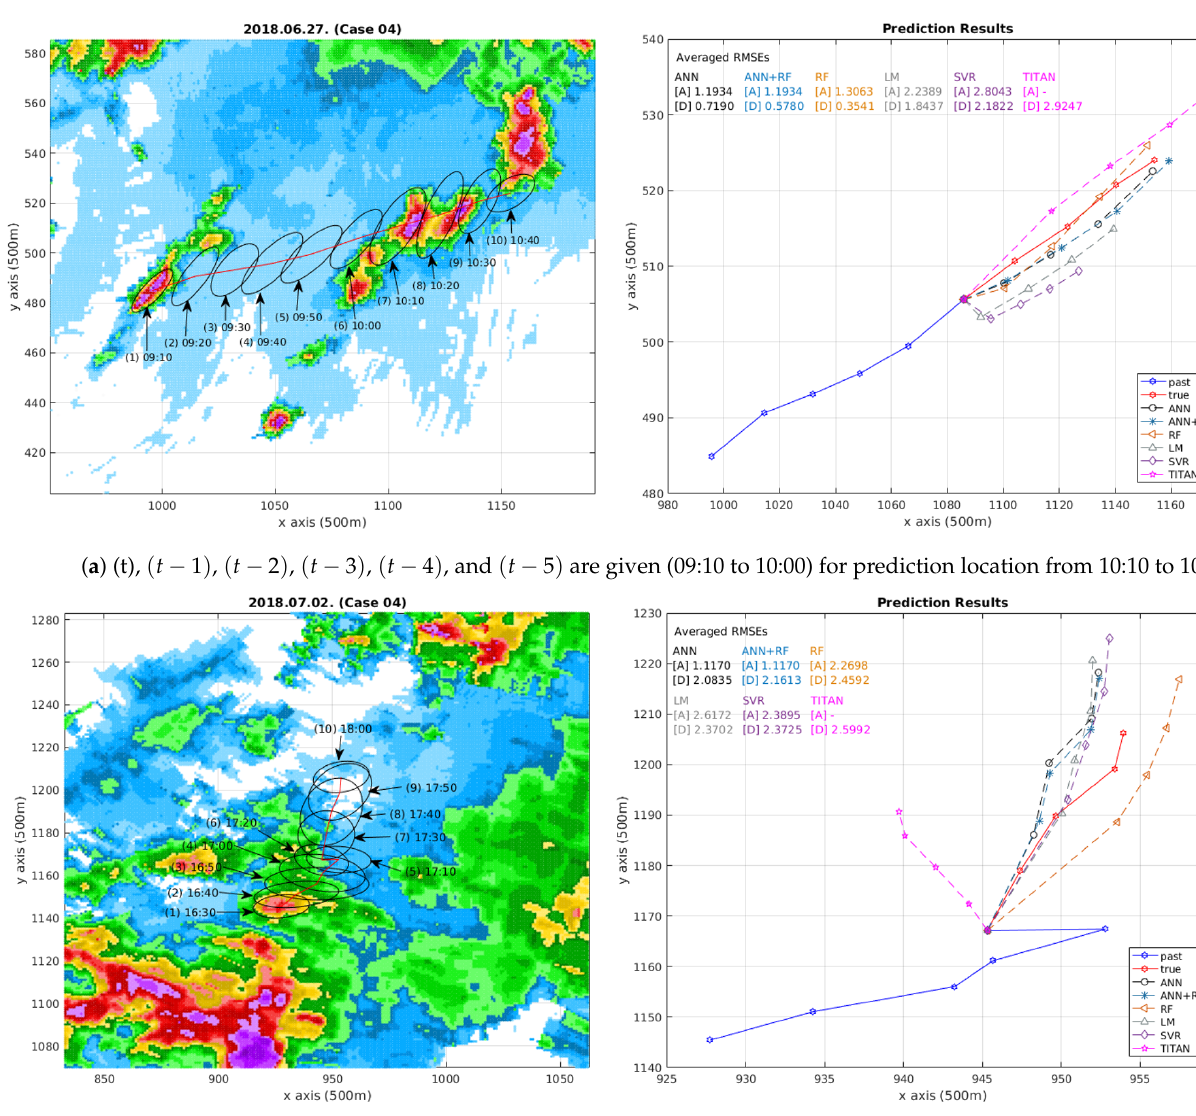
Figure 8. Observed trajectories and prediction results for comparing proposed methods and